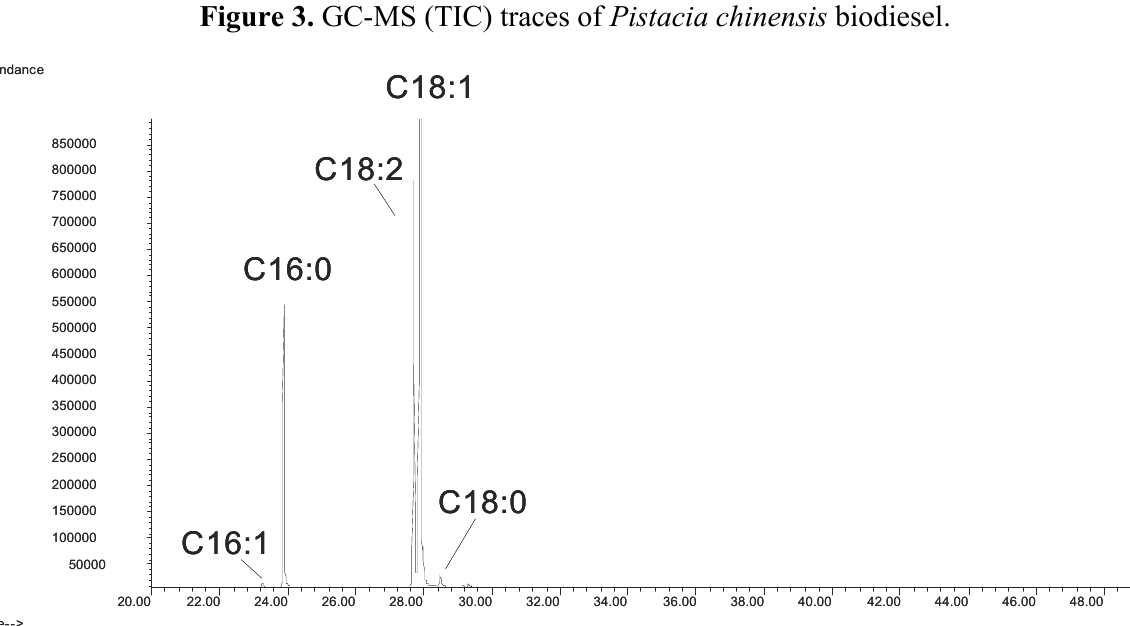
Figure 3. GC-MS (TIC) traces of Pistacia chinensis biodiesel.